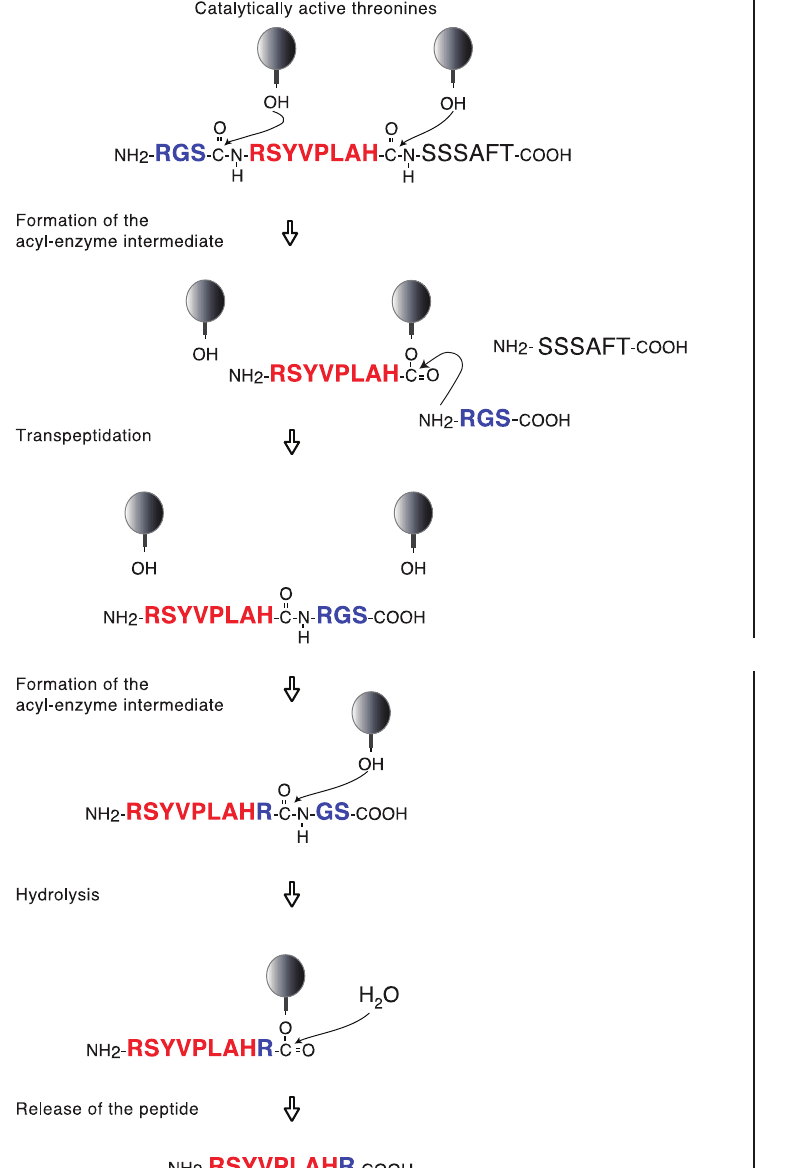
Figure 2. Peptide splicing and trimming of the antigenic peptide RSYVPLAH_R derived from gp100 by the proteasome. In the course of peptide-bond hydrolysis, the hydroxyl group of the N-terminal threonine produces a nucleophile attack on the carbonyl of the peptide bond. This leads to the formation of an acyl-enzyme intermediate in which the peptide fragment RSYVPLAH remains attached to the proteasome through an ester link. Normally, this acyl-enzyme intermediate is rapidly hydrolyzed. However, peptide fragments, such as RGS, present in the chamber can compete with water molecules, their free N-terminal amino-group performing a nucleophilic attack on the acyl-enzyme intermediate. This transpeptidation leads to the creation of a new peptide bond, which assembles both fragments, leading to the formation of a spliced peptide bearing an extended C-terminus. The C-terminal extension is then further trimmed by the proteasome to release the antigenic peptide, RSYVPLAHR. Balls represent the catalytic (cid:4) subunits of the proteasome. The hydroxyl group of the N-terminal threonine is